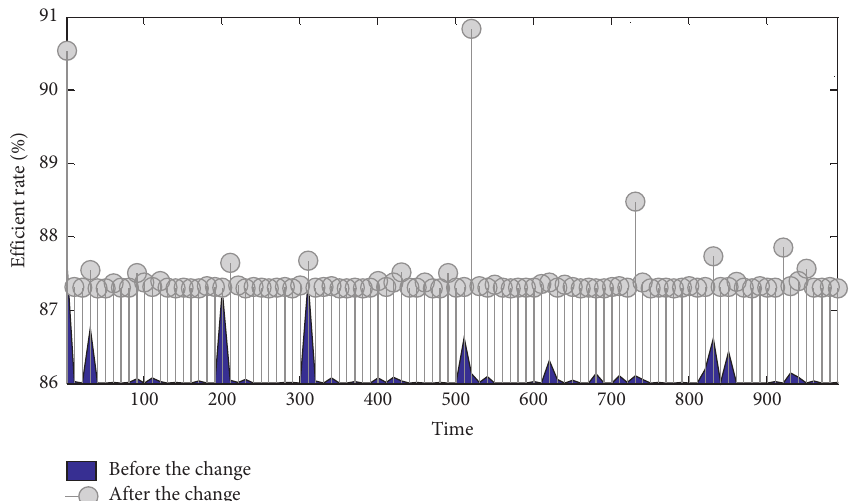
Figure 5: The effectiveness of the multidimensional learning space index at different